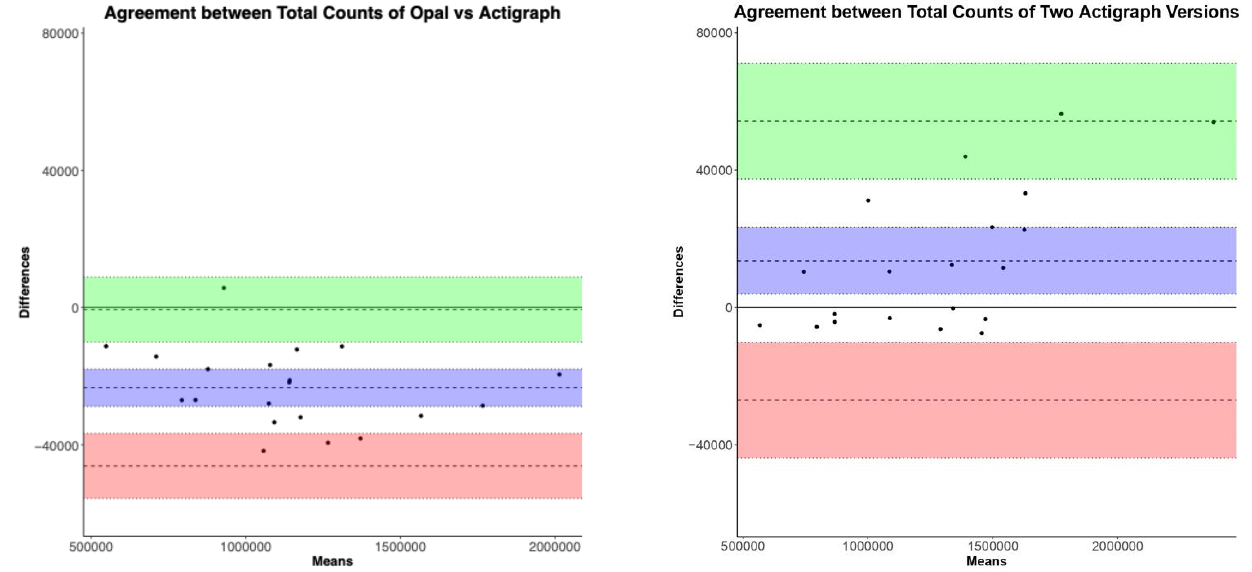
Figure 1. Bland – Altman plots of total counts using Freedson98 algorithm. Figure 1. Bland–Altman plots of total counts using Freedson98 algorithm.